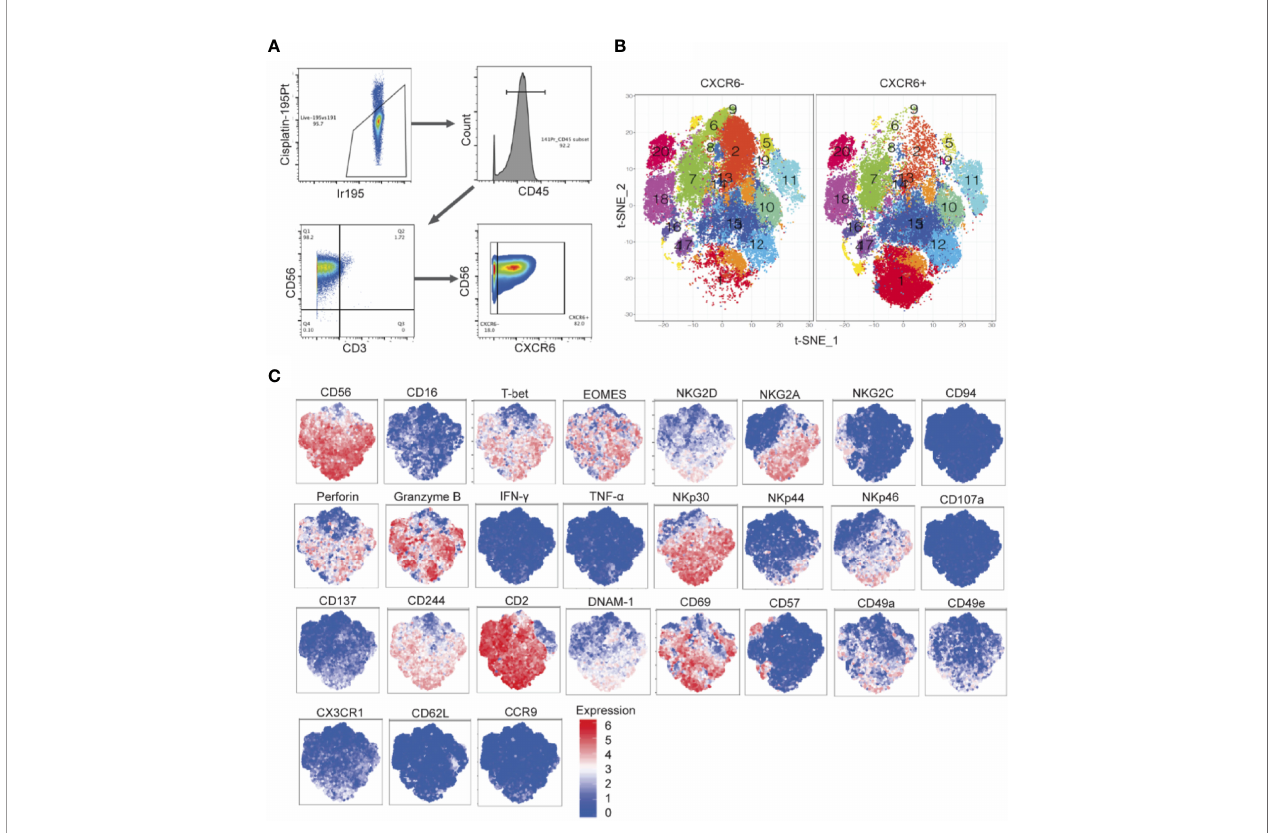
FIGURE 7 | Mass cytometry immunophenotyping detects subsets of CXCR6 + NK cells with diverse expression patterns, distinct from that of CXCR6- NK cells. (A) Hierarchical gating strategy of cultured PBMC derived CXCR6 + and CXCR6 - NK cell cultures. CXCR6 + and CXCR6 - NK cells were single cell sorted from PBMCs ( n=8 donors) and cultured with IL-15 and CXCL16 feeder cells for 2-7 weeks. Cultured cells were stained for 32 cell surface and intracellular targets and analyzed by mass cytometry. (B) t-Distributed Stochastic Neighbor Embedding (t-SNE) dimensionality reduction and Rphenograph clustering of CXCR6 + and CXCR6 - NK cells. (C) Expression patterns of selected